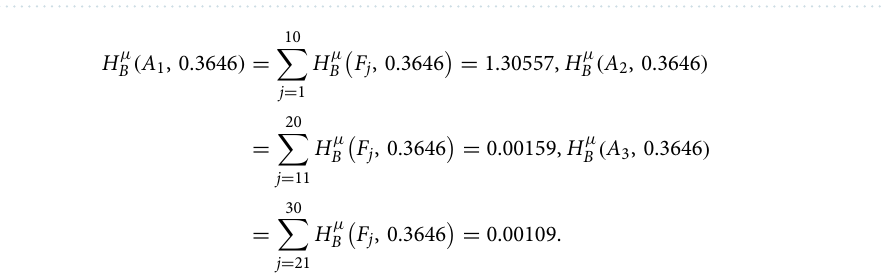
Figure 7. In middle frequency range: ( a ) FCE measure values for various faults types (b) Comparison sum of measure values of the Shiang and Jiang method 23 , Bhandari and Pal method 23 and the proposed method for SC, AD, and RD